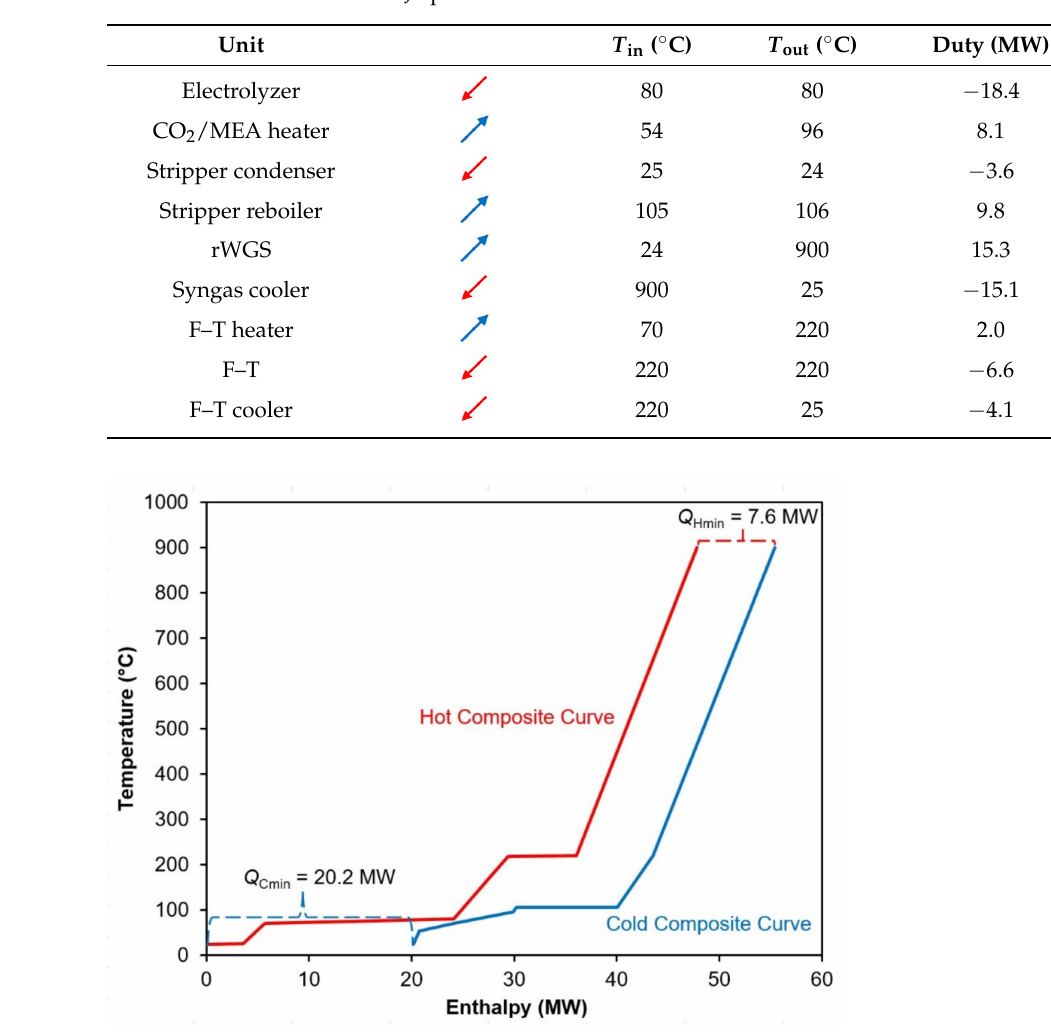
Figure 3. Composite curves for the heat exchange stream data of the BEJF process at ∆ T min = 10 ◦